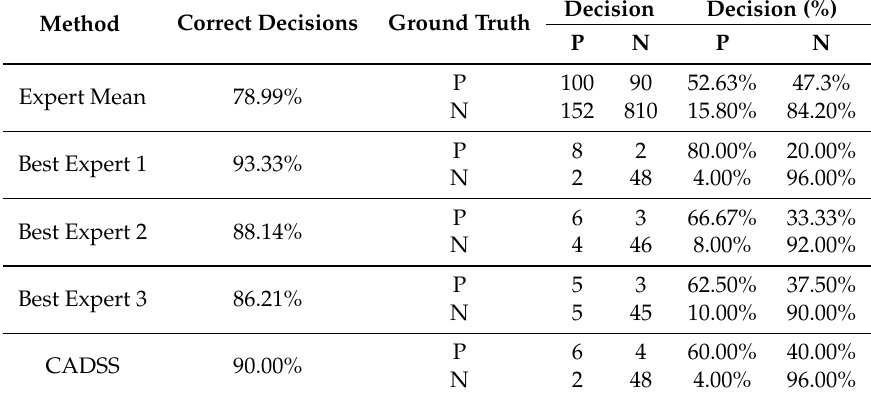
Table 4. The table shows the mean value of the results of the 26 experts, the results of the three best experts, and the outcome of the CADSS presented in [182]. Detailed performance indicators are shown, such as the percentage of correct decisions, the number of positive and negative decisions given in each case, and the corresponding rate of true and false positives and true and false negatives. Ground truth refers to the real nature of each CFS case (P = Positive, N =